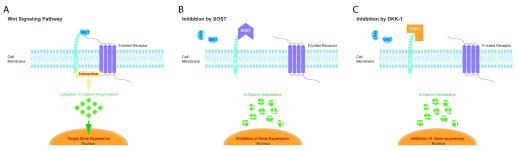
Inhibition of Wnt signaling by sclerostin and dickkopf-1.Scheme of the Wnt signaling pathway (
A) which is inhibited by sclerostin (SOST,
B) and dickkopf-1 (DKK-1,
C). Adopted from (
Yorgan & Schinke, 2014) and modified.